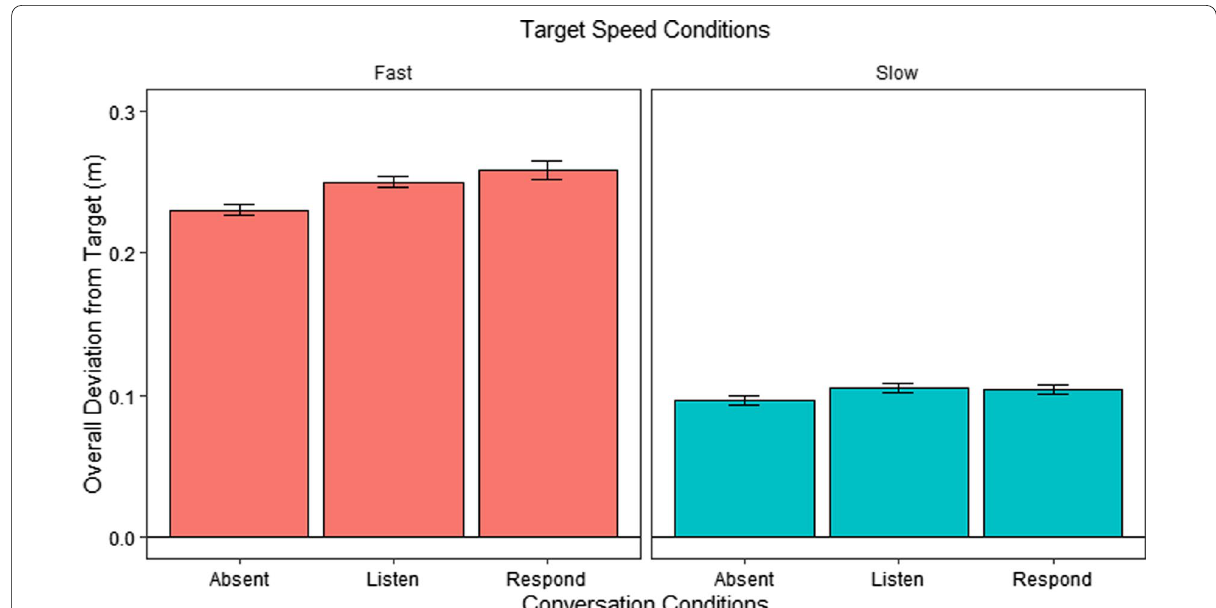
Fig. 2 Overall deviation from target during different conversation conditions in Fast and Slow speed conditions in E1. Error bars show the standard error of the mean